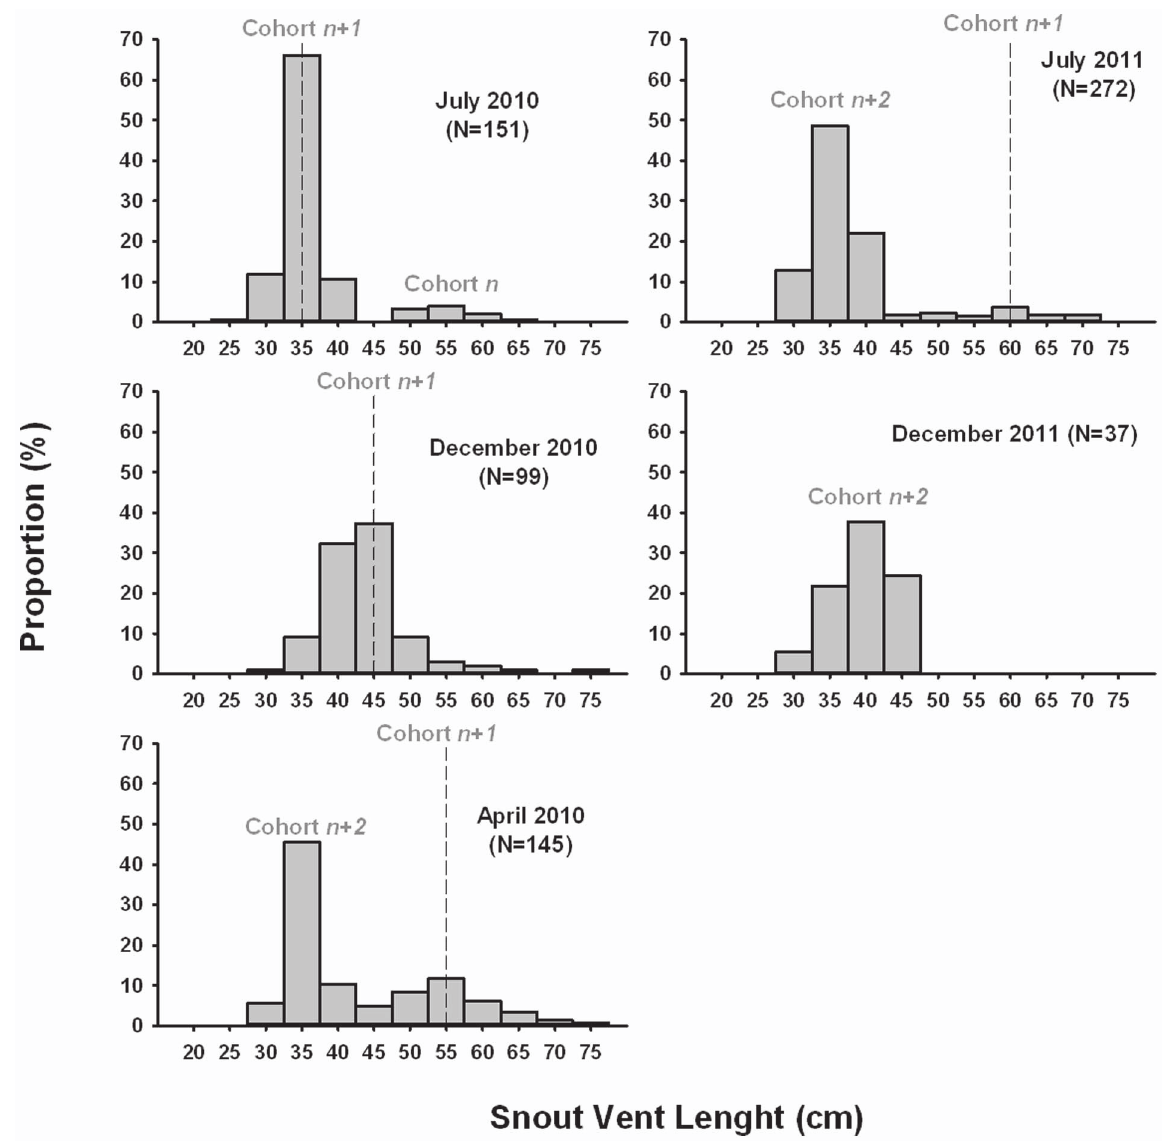
Figure 3. Changes in body size distribution (X-axis) observed in small sea kraits (neonates + juveniles) over time in Ouen Island. The site was monitored during seven sessions (2010–2011), but we pooled sessions that were separated by less than three weeks (e.g. July & August 2011), resulting into 5 main periods. Different size cohorts, hence age cohorts, are visible. Recaptures of several individuals provide a strong support for the suggested succession of cohorts (cohort n, n + 1, n + 2 ; see text). Neonates (less than 50 cm SVL) grow rapidly and generate a shift toward larger body size from winter (July) to summer (December). This is indicated for the cohort n + 1 with the dashed lines.